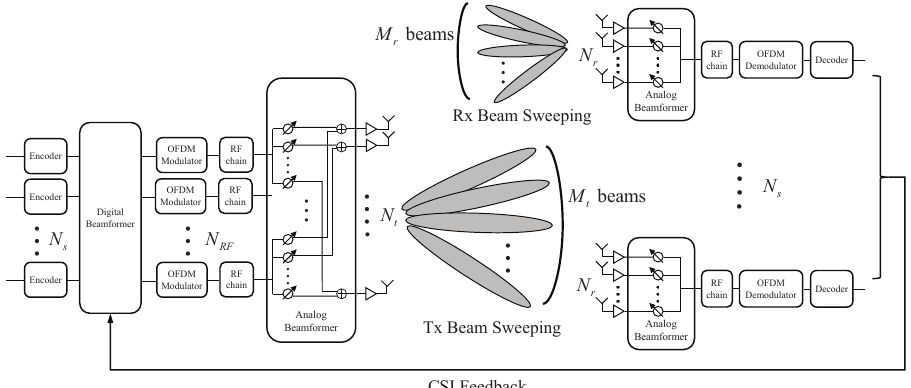
Figure 1. Multi-user hybrid beamforming